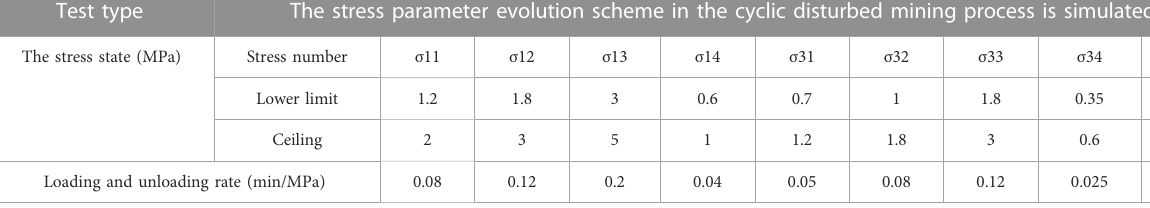
TABLE 1 Schemes of simulated cyclic mining disturbance stress